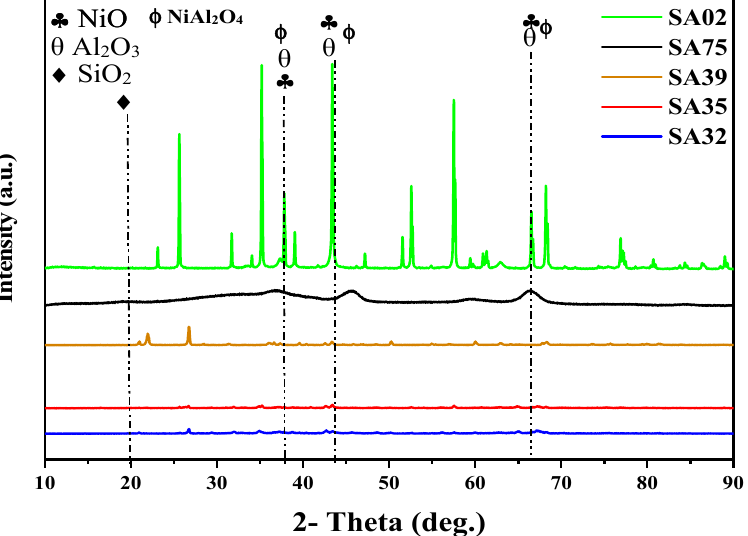
Figure 3. XRD patterns of fresh Ni-supported catalysts.